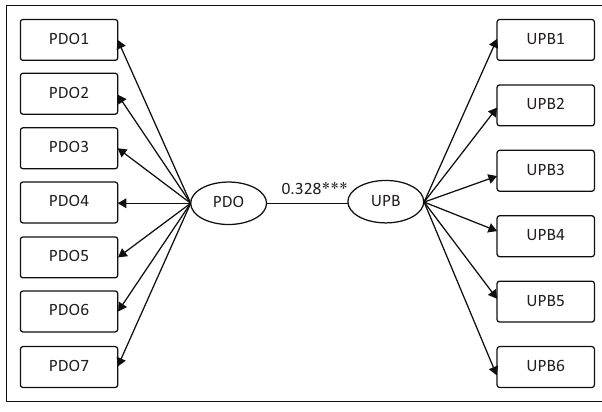
FIGURE 2: Structural equation model results for power distance